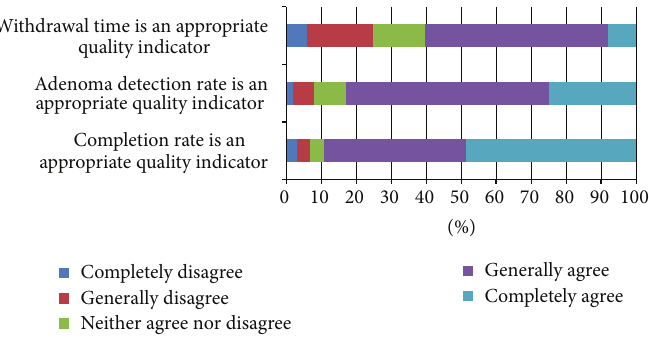
Figure 1: Physician perceptions about colonoscopy quality